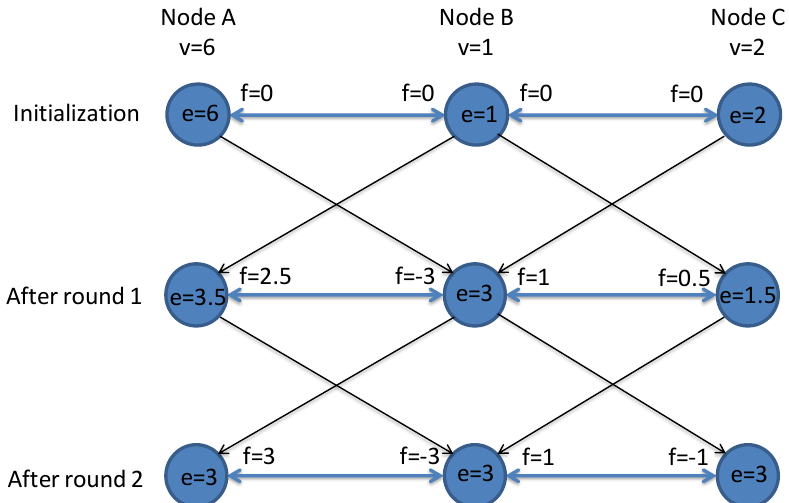
Figure 2. Example of the Flow Updating algorithm with three